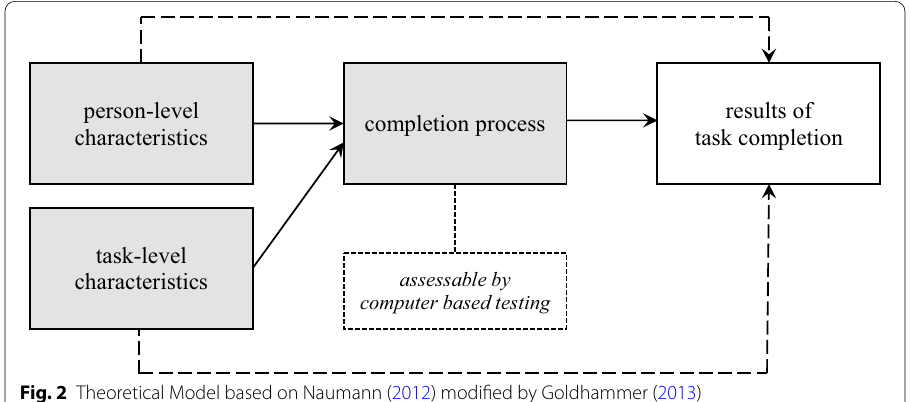
Fig. 2 Theoretical Model based on Naumann (2012) modified by Goldhammer